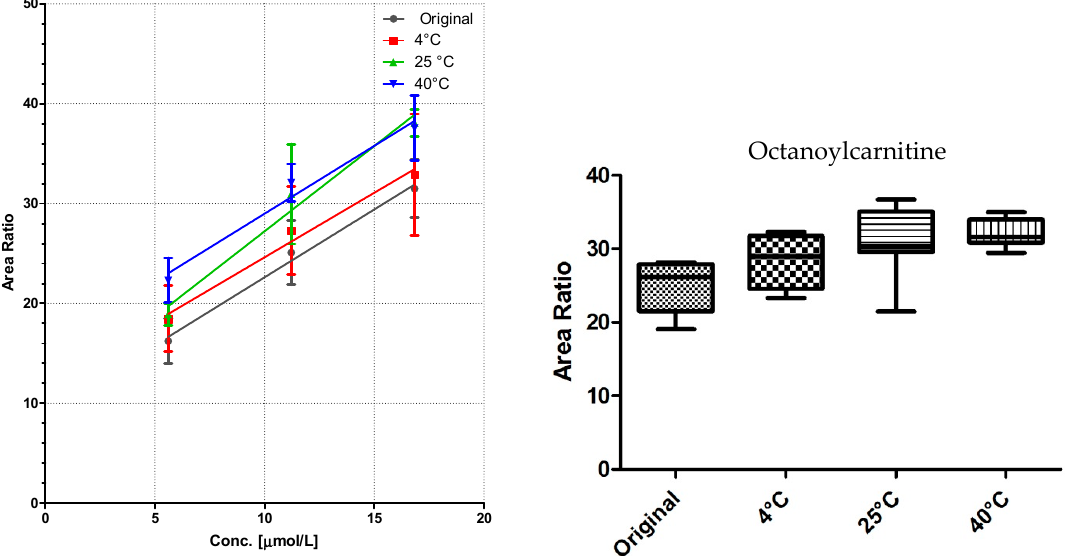
Figure 4. LC-MS/MS analysis of octanoylcarnitine from DBS cards stored at different storage temperatures: ( left ) linearity (mean ± sd of n = 7); and ( right ) box and whiskers graph of level 2 with 5–95 percentiles of the same data.